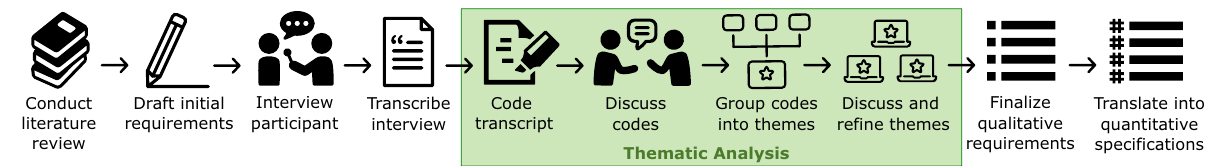
Figure 4: A diagram illustrating the fl ow of our process and the links between our literature review, interview study, and resulting themes. The thematic analysis portion of our study is highlighted in green. The identi fi ed themes were used to re fi ne our initial requirement list into fi nalized qualitative requirements, which we then translated into quantitative speci fi